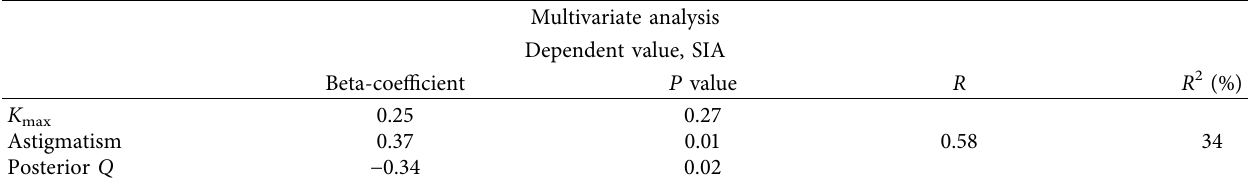
Table 3: Multivariate analysis of possible confounding corneal parameters for SIA.